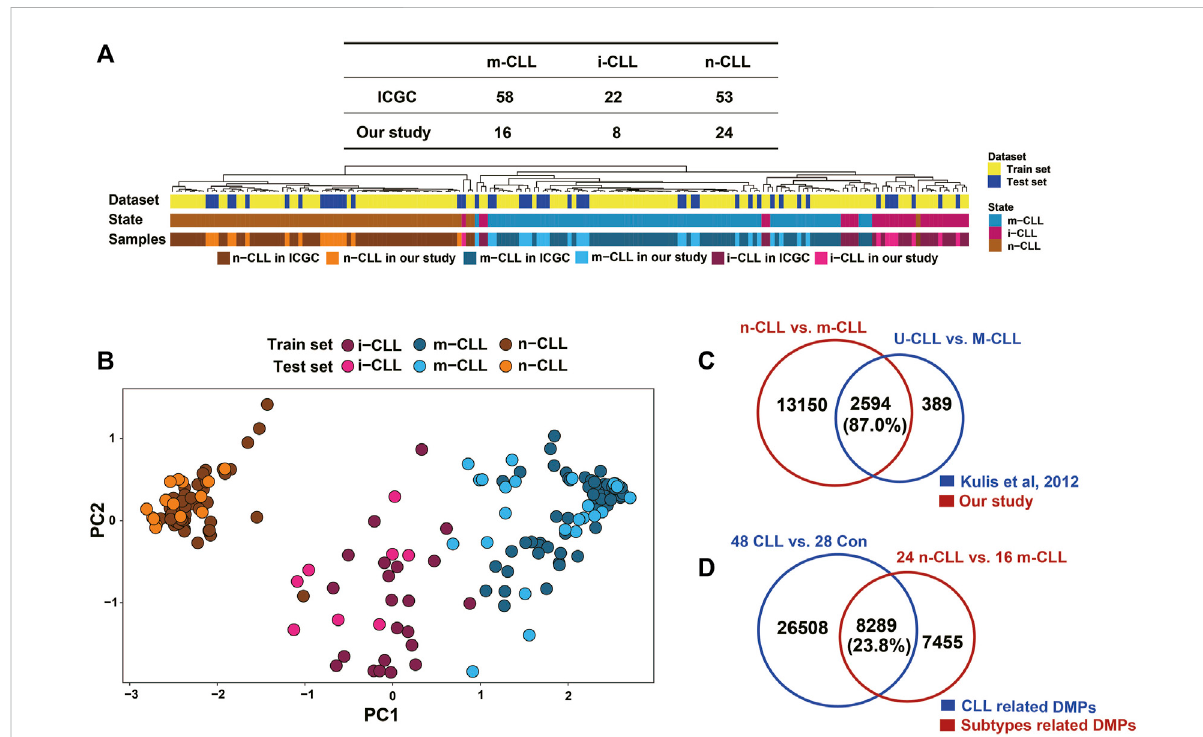
FIGURE 5 SubgroupsinCLLpatientsclassi fi edbymethylationpattern. (A) ClusteringshownSVMmodelingofmethylationdatarevealedCLLsubgroupsin our study. SVM model (Radial Basis Kernel, C = 10, γ = 0.01) was conducted with fi ve CpGs (cg00869668, cg03462096, cg09637172, cg11472422, cg17014214) from were used as train datasets according to AC Queirós et al, 2014. CLL patients were classi fi ed into three subgroups of 16 m-CLL, eighti-CLL, and24n-CLL. (B) Principalcomponentanalysison theMvalueofthis fi veCpGsof48CLLpatientsinourstudy.Threesubgroupsof CLL patients could be more closely with the training dataset. (C) A comparison of DMPs (N = 15,744) between m-CLL and n-CLL and the previously reported DMPs (N = 3,626) distinguishing M- and U-CLL from Kulis et al., 2012 . (D) A comparison of the CLL-related DMPs (N = 34,797) identi fi ed in our study with DMPs (N = 15,744) distinguishing m-CLL and n-CLL subgroups in our dataset. n-CLL: NBC-like CLLs; m-CLL: MBC-like